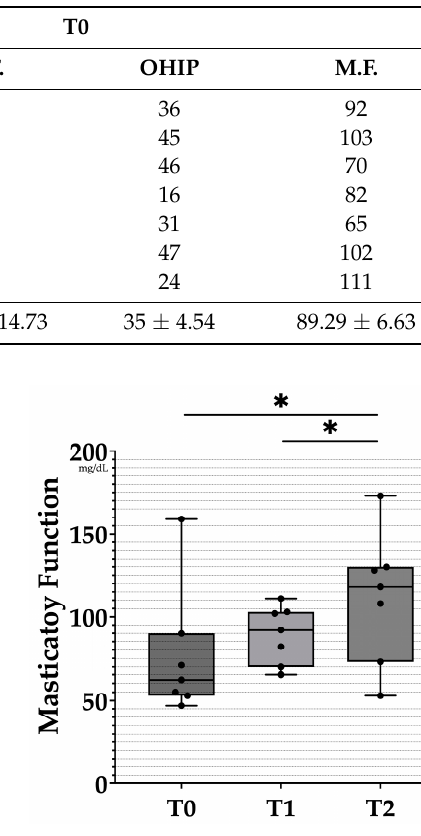
Table 2. All acquired data, mean values, and standard deviations. T0: before the clinical remount. T1: immediately after the clinical remount. T2: 1 week after the clinical remount. MF: masticatory